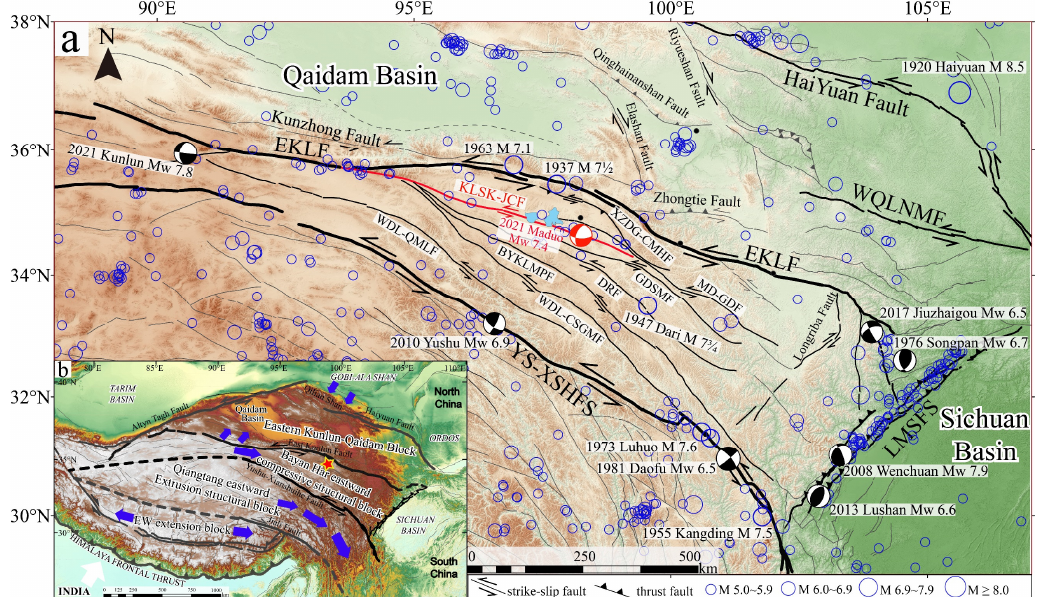
Figure 1. ( a ) Seismotectonic map of Bayan Har Block in the northern Qinghai–Tibet Plateau. The active faults were modified from Deng [30]. Epicenters before 1976 were taken from China earthquake network center. Epicenters and Focal mechanism solutions of strong earthquakes (Mw ≥ 6.5) around the Bayan Har Block since 1976 were taken from the Global Centroid-Moment Tensor seismic catalog (https://www.globalcmt.org/). ( b ) Index map of the study area in the Tibetan Plateau. Block boundary was referred from Tapponnier [31]. (EKLF—East Kunlun Fault, WQLNMF—West Qinlin north margin Fault, YS-XSHFS—Yushu-Xianshuihe Fault system, LMTFS—Longmenshan Thrust Fault system, XZDG-CMHF—Xizangdagou-Changmahe Fault, MD-GDF—Maduo-Gande Fault, GDSMF—Gande South margin Fault, BYKLMPF—Bayan Har main peak Fault, WDL-QMLF—Wudaoliang-Qumalai Fault, and WDL-CSGMF—Wudaoliang-Changshagongma Fault). Besides the major boundary faults around the Bayan Har Block, a sequence of parallel part of the Block, which are the Maduo-Gande Fault, Jiangcuo Fault, Gande south margin Fault, Dari Fault, Bayan Har main peak Fault, and the Wudaoliang-Changshagongma Fault from north to south (Figure 1a). Little research has focused on these faults because of the remote and hard access. Based on the interpretation of satellite images and a field investigation, Xiong (2010) identified the 50 km long surface rupture of the Maduo-Gande Fault and suggested that the maximum sinistral horizontal and vertical displacements were 7.6 m and 4 m, respectively [32]. Liang (2020) analyzed the surface rupture of the